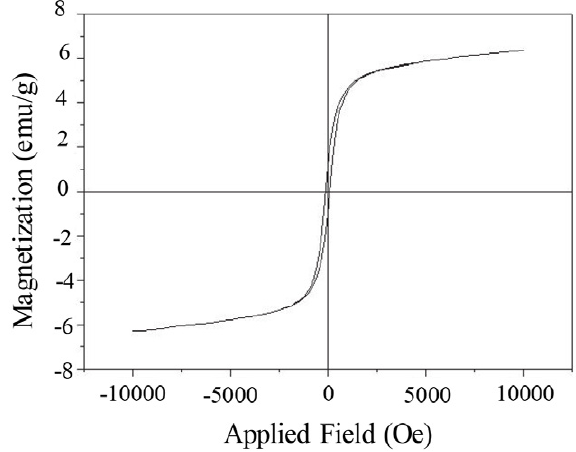
Figure 5. Magnetic behavior of MnFe 2 O 4 nanoparticles